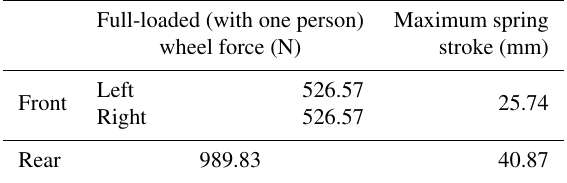
Figure 13. Schematic diagram for tie rod parameter change. Table 3. Full-loaded wheel force and maximum spring stroke.